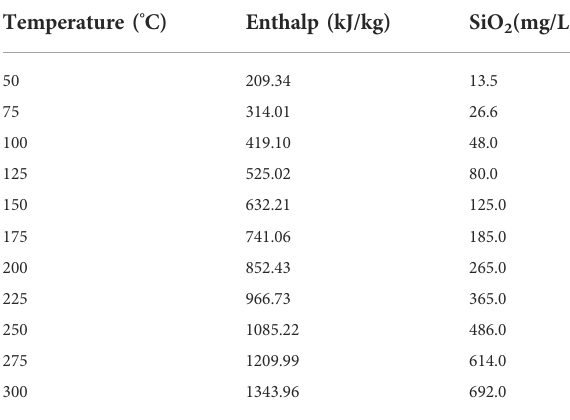
FIGURE 8 The mixing